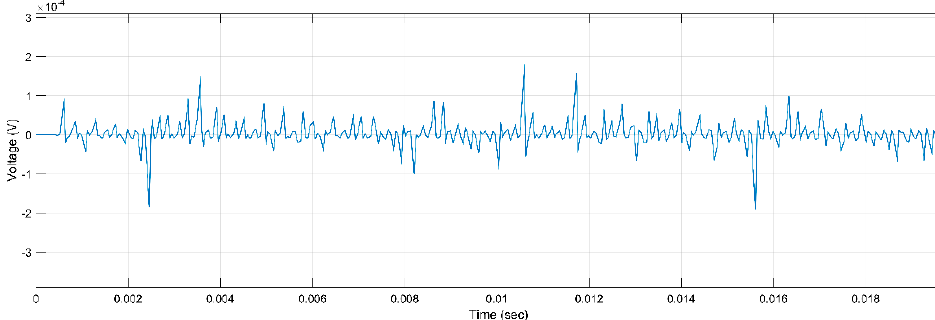
Figure 19. PD Activity for Combination, 5 kV, h, r.